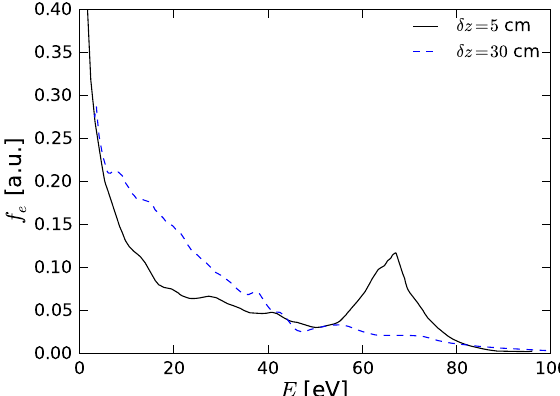
Fig. 9. Suprathermal part of the electron distribution function measured using a swept Langmuir probe 5 and 30cm away from the beam source in the direction of the background magnetic